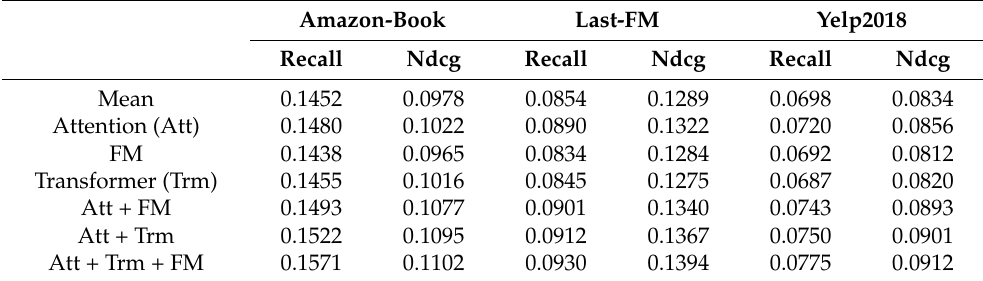
Table 4. Effect of